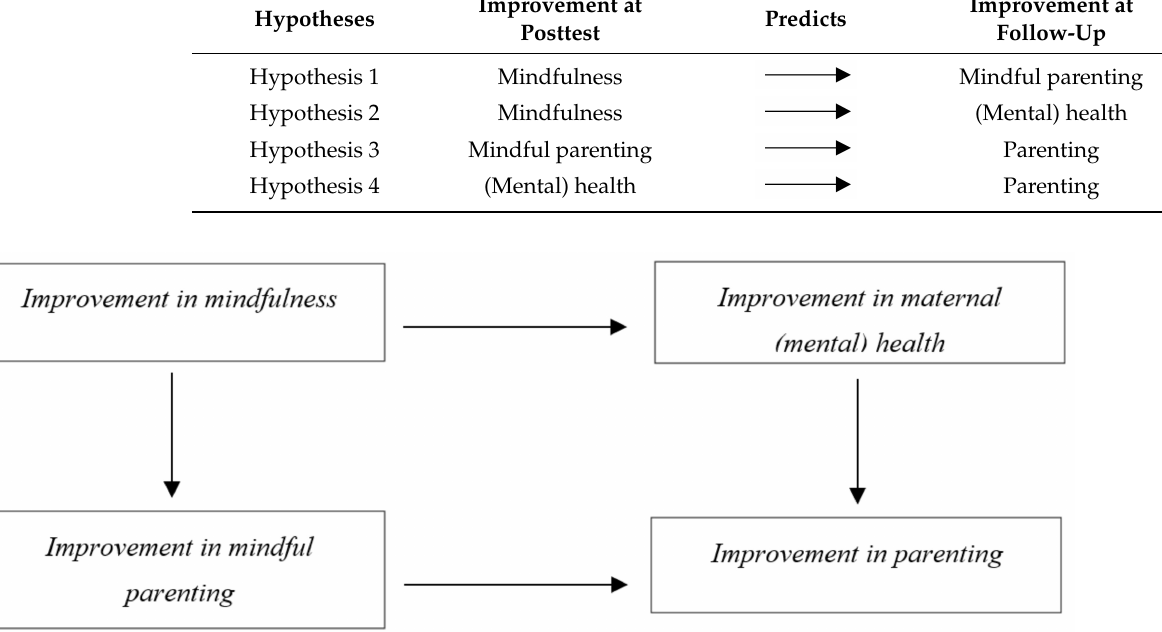
Figure 1. Hypotheses on the working mechanisms of Mindful with Your